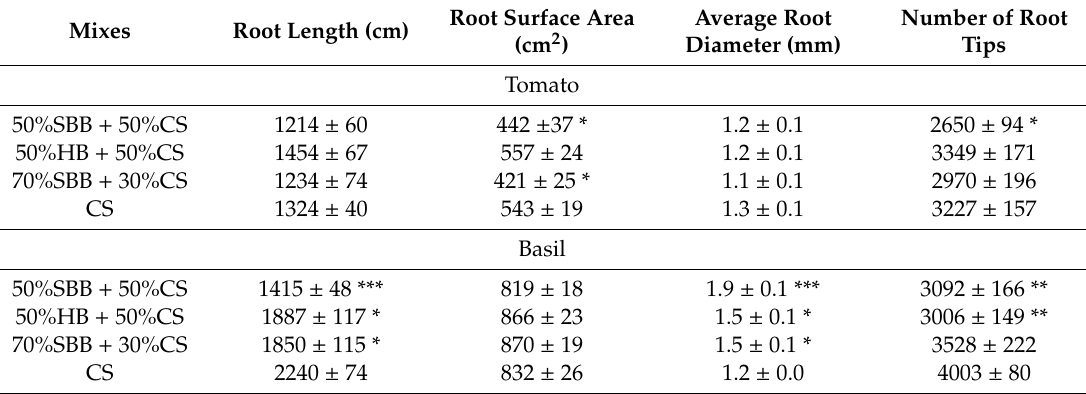
Table 2. The root development (mean ± standard error) of plants grown in potting mixes with 50% sugarcane bagasse biochar (SBB), 50% mixed hardwood biochar (HB), and 70% SBB (by vol.) mixed with bark-based commercial substrate (CS). *, **, and ***indicated significant di ff erences from CS